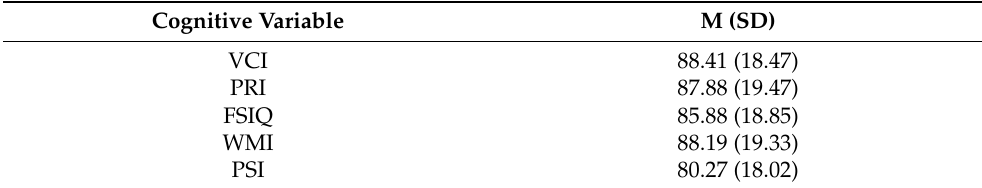
Table 2. Mean (M) and standard deviation (SD) for the Wechsler Intelligence Scale for Children, 4th Edition indexes. VCI: Verbal Comprehension Index; PRI: Perceptual Reasoning Index; FSIQ: Full Scale Intelligence Quotient; WMI: Working Memory Index; PSI: Processing Speed